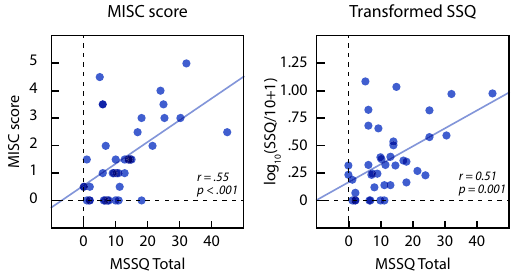
Fig. 12 Cybersickness experienced by individual subjects in Experiment 2 plotted as a function of self-reported motion sickness susceptibility (MSSQ total). Lines show the regression fits. The left graph plots the MISC scores and right graph plots the SSQ after transforming by log 10 (SSQ/10 +